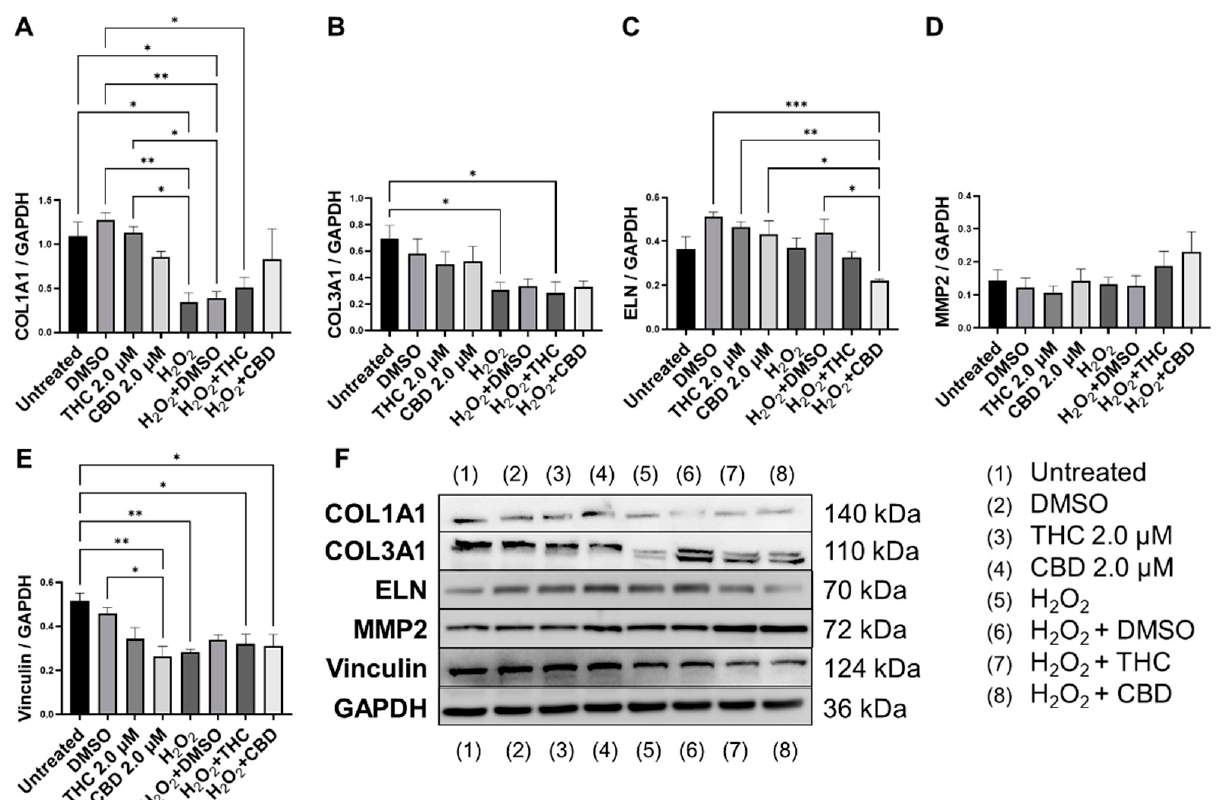
Figure 7. Effects of phytocannabinoids on extracellular matrix proteins in CCD-1064Sk human dermal fibroblasts (PDL 24). Relative densitometry was presented as a ratio of the target protein relative to GAPDH for expression of ( A ) COL1A1, ( B ) COL3A1, ( C ) ELN, ( D ) MMP2, and ( E ) Vinculin, ( F ) representative images blots with each protein detected. Original membranes can be seen in Figures S5–S10. Data were analyzed with an ANOVA test followed by Tukey’s post-hoc multiple compari- son test. Bars represent mean ± SEM, n = 3. Significance is indicated using the following scale: * p < 0.05, ** p < 0.01, *** p < 0.001. CBD, cannabidiol; DMSO, dimethyl sulfoxide (vehicle); THC, delta-9- tetrahydrocannabinol.